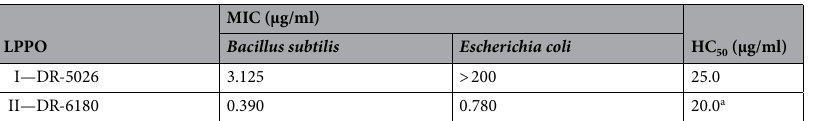
Table 1. Antimicrobial and hemolytic activity of selected first- and second-generation LPPOs. Antimicrobial and hemolytic activity are expressed as minimum inhibitory concentration (MIC) and the concentration causing lysis of 50% of red blood cells (HC 50 ), respectively. a Previously 16 µg/ml 18 , volunteer blood donor changed.